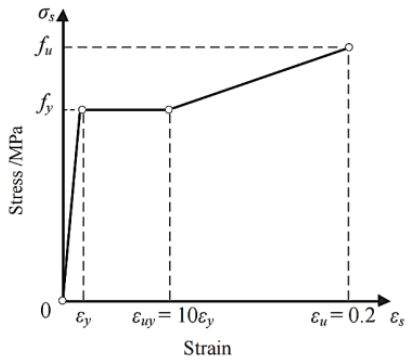
Figure 5. Steel constitution. Figure 5. Steel